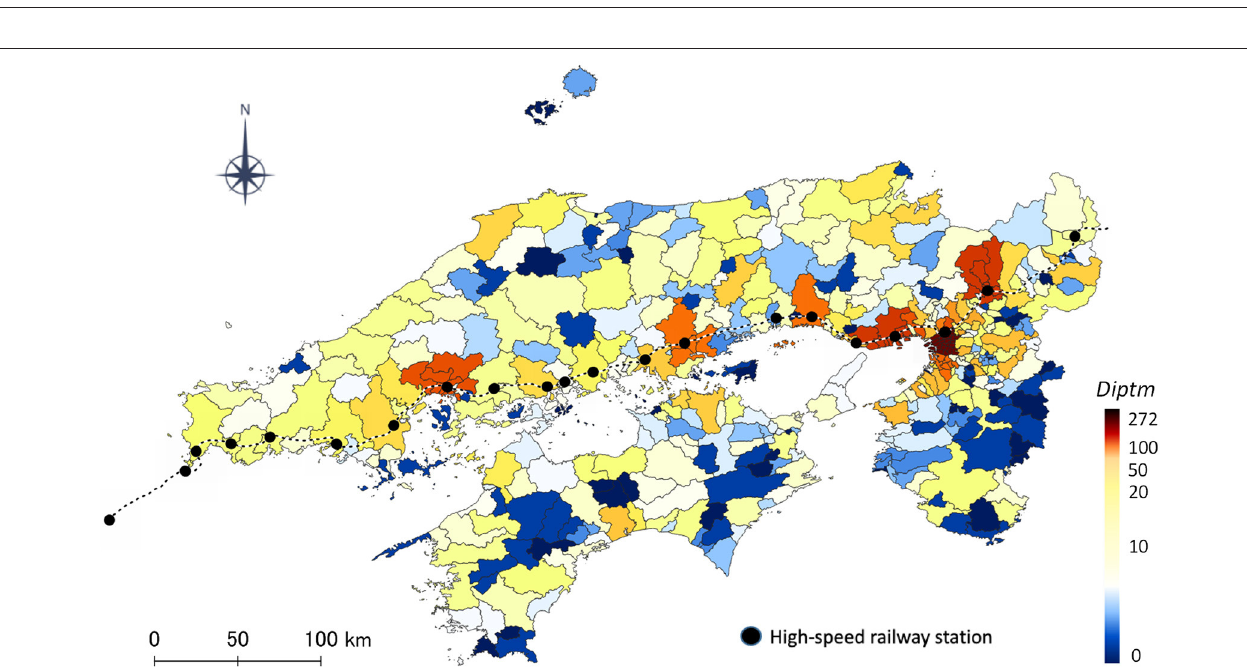
FIGURE 5 | Diptm of cities excluding the effects of high-speed